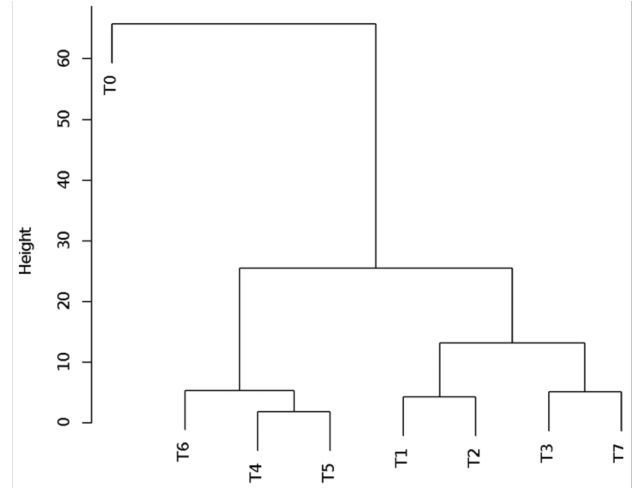
Figure 4. Clustering by treatment. T0: Soil without treatment; T1, T2, and T3: soils treated with lime at 1, 2, and 3%, respectively; T4, T5, and T6: soils treated with 40 nm silica nanoparticles at 0.5, 1, and 2%, respectively; T7: soil treated with 0.5% nanosilica and 2% lime.